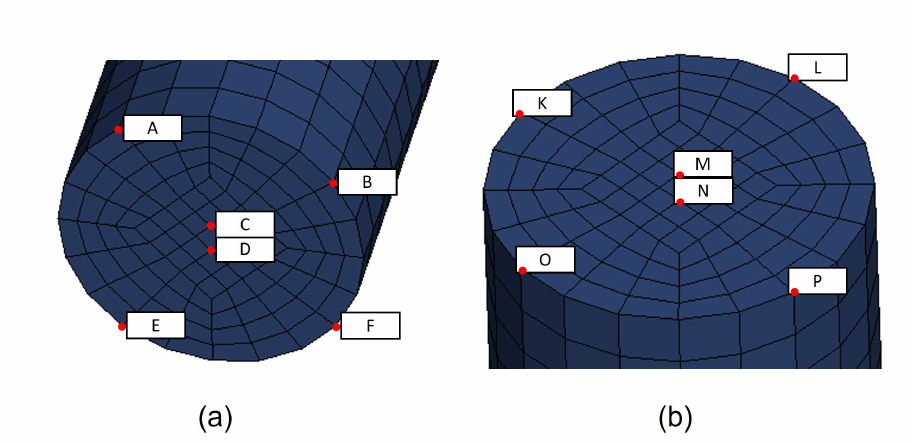
Figure 15. Trackers Position: ( a ) Under The Jellyroll. ( b ) Above The